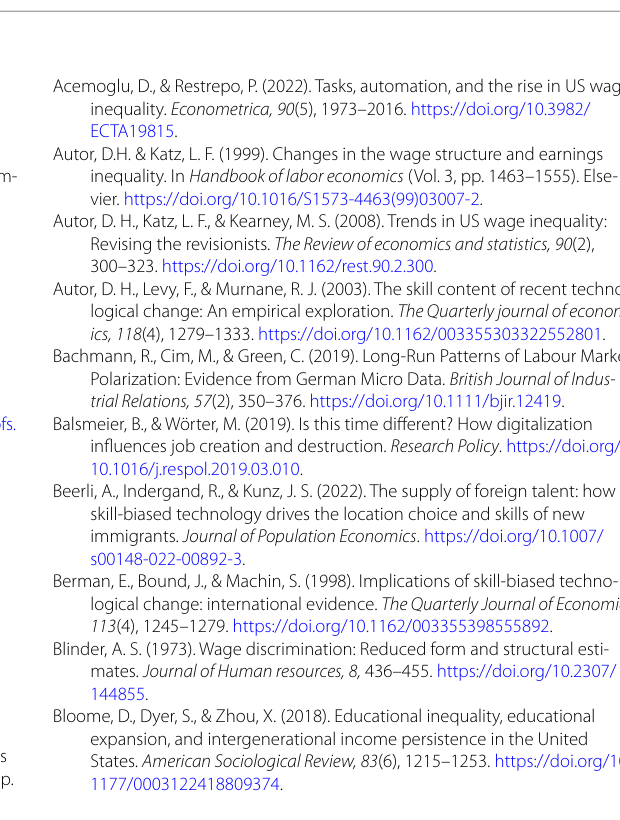
Fig. 7 Transition Rates for Inflows into Non-Routine Cognitive Jobs. Notes: Transition rate computation is explained in chapter 3.2, blue lines show local regression lines, and the gray area marks the 95% confidence interval. The figure also includes the stayer rate (NRC → NRC), the share of non-routine cognitive workers remaining in non-routine cognitive employment. Source: Swiss Labour Force Survey,